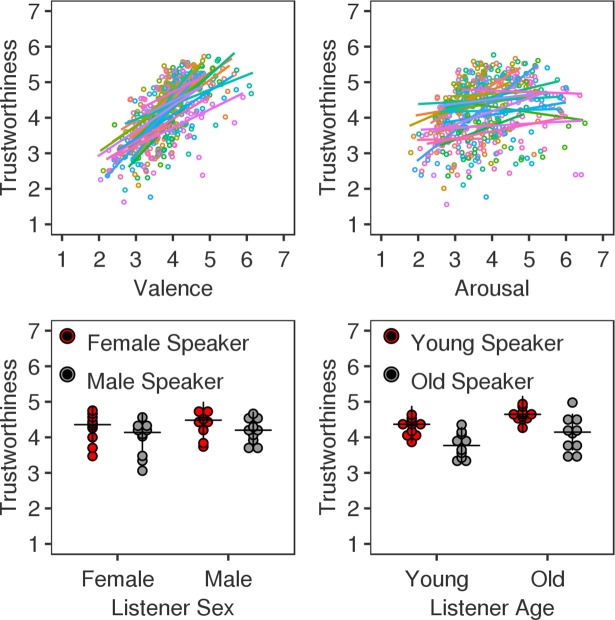
Trustworthiness rating results.Top row—The scatter plots illustrate the relation between valence and trustworthiness (left) and arousal and trustworthiness (right). Colours represent individual speakers (N = 20) in a consistent manner across the two graphs. Data points reflect trustworthiness averages for each expression and sentence computed across listeners and are summarized with a regression line. Bottom row–Plots illustrating the interaction of speaker and listener characteristics for sex (left) and age (right), respectively. Female and younger speakers are represented by red dots, whereas male and older speakers are represented by grey dots. Data points reflect trustworthiness averages for speaker computed across expressions, sentences and listeners. Median values are marked by a black cross.